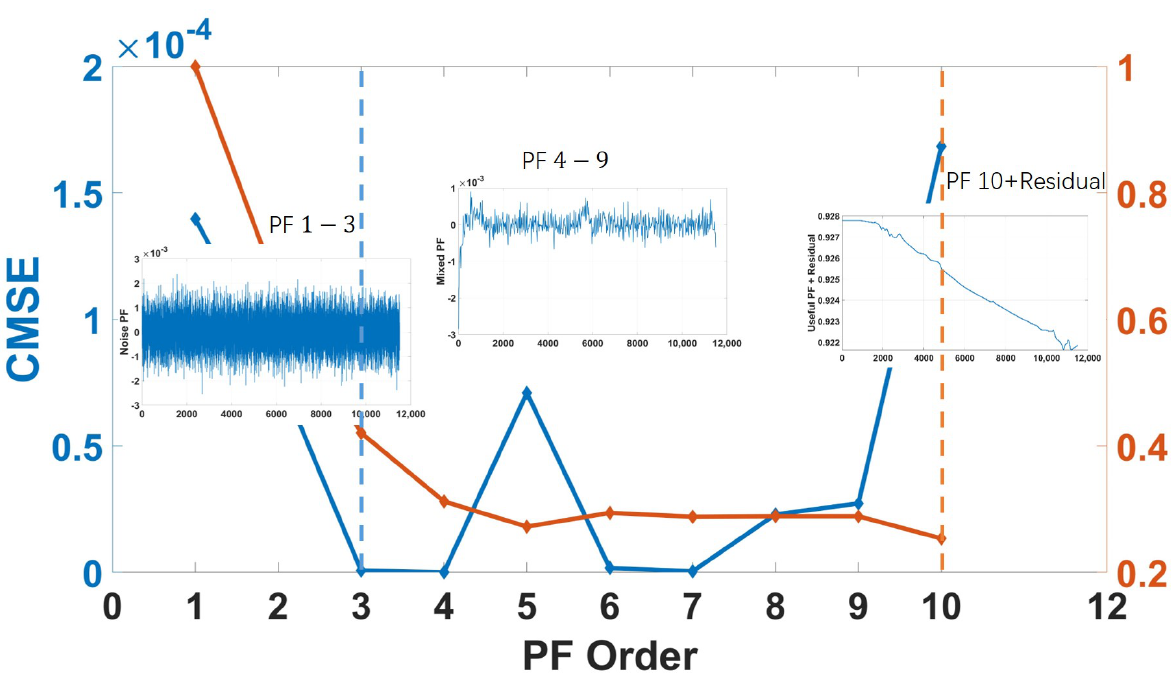
Figure 7. PF classification based on CMSE and PE.